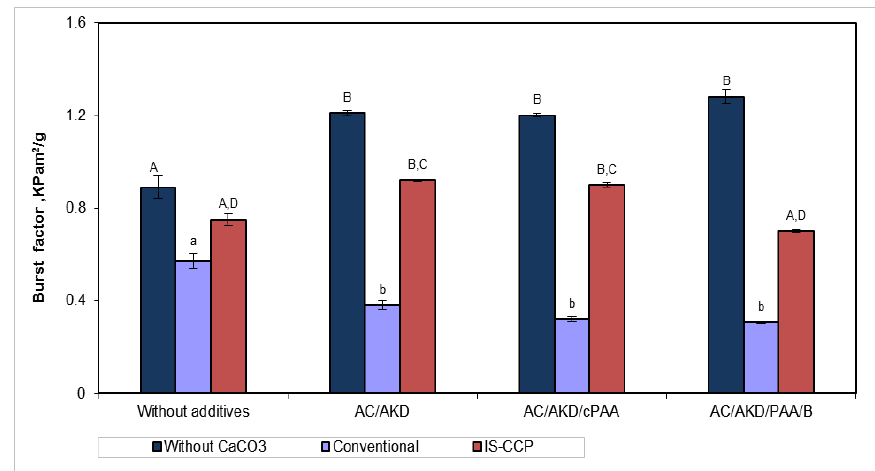
Figure 9. Breaking length for different additive systems in relation with paper composition (different letters within the same method—capitals for w/o CaCO 3 and, respectively IS-CCP and small letters for conventional designate statistical difference, p < 0.05).